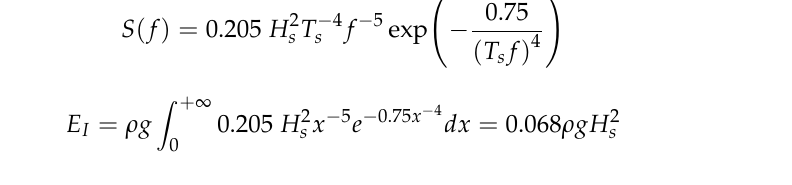
Table 1. Four test cases with different sea levels.